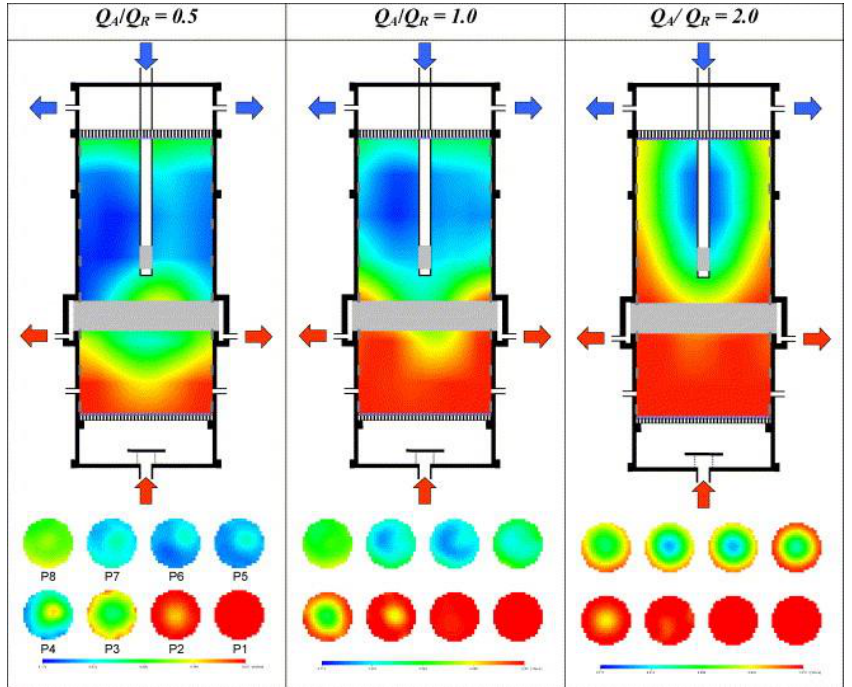
Figure 4. Tomographic images of a liquid with a certain concentration, a liquor, flowing through a packed bed of HDPE pellets at steady flow conditions, obtained using a set of sensing electrode rings located sequentially along a pipe (the planes are numbered from the bottom, starting with number 1). A step reduction in liquid conductivity was made in the flow exiting the down comer. Images display the liquid concentration distribution at steady-state flow ratios of Q A / Q R of 0.5, 1.0 and 2.0. A total liquid flux of 75 mL/s was used for Q A / Q R of 0.5 and 2.0, and of 50 mL/s for Q A / Q R equal to 1.0. In the tomographic diagrams, low conductivity regions are coloured blue and high conductivity regions are coloured red (Reproduced with permission from Ruzinsky et al. [126]).